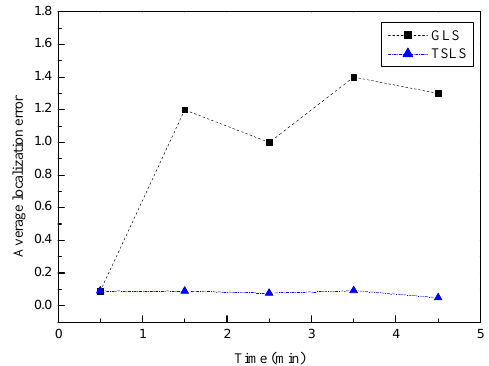
Fig.8. Average localization error of unknown nodes when adding beacon nodes into the